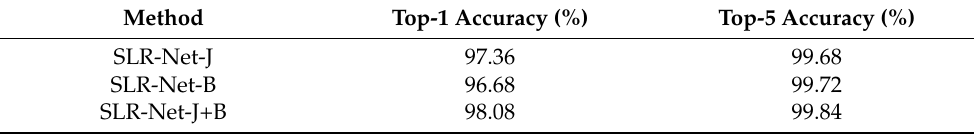
Table 8. The results of two-stream framework on CSL-500 dataset.